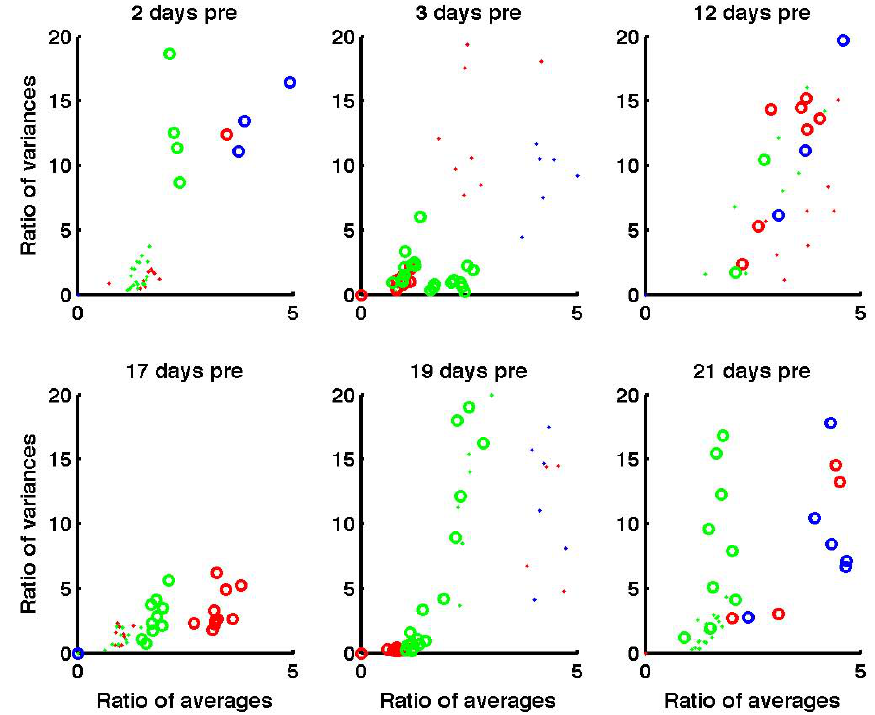
Fig. 3. Ratios of the mean and variance of ULF wave power measured at distances of < 500km (blue), 500 < D < 1000km (red), and 1000 < D < 1500km (green) to the wave power measured at distances of 1500 < D < 2000km from the epicentre. Daytime passes are shown by the open circles, night-time by dots.